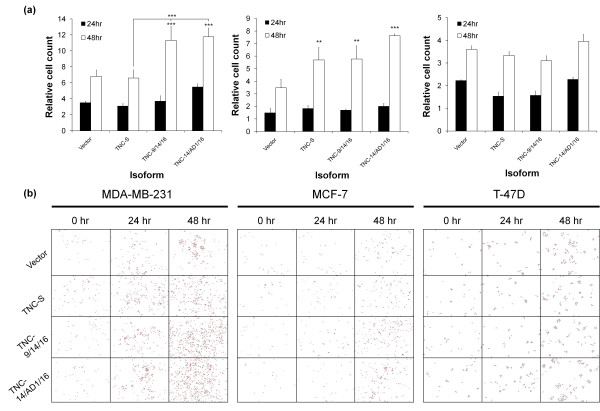
Direct effect of tenascin-C isoform expression on tumour cell growth. (a) Growth of MCF-7, MDA-MB-231 and T-47 D cell lines transfected with three different tenascin-C (TNC) constructs and a vector control. Bars represent the mean relative cell count compared with 0 hours, with each assay performed three times in triplicate; error bars shown. (b) Images of cells transfected with three different TNC constructs. Images were taken using a 4× magnification in exactly the same position in each well. **P < 0.01, ***P < 0.001.